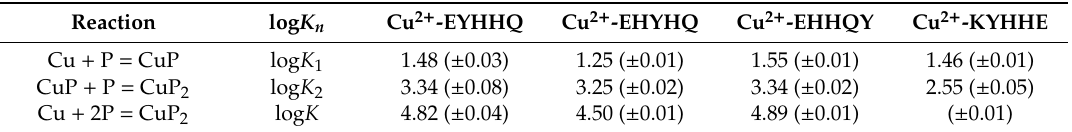
Table 1. log K values (standard deviation in parentheses) for the Cu 2 + -peptide complexes in 5 mM MES bu ff er solution (pH 6.0) calculated for T = 25 ◦ C: Cu and P denote the Cu 2 + ion and the